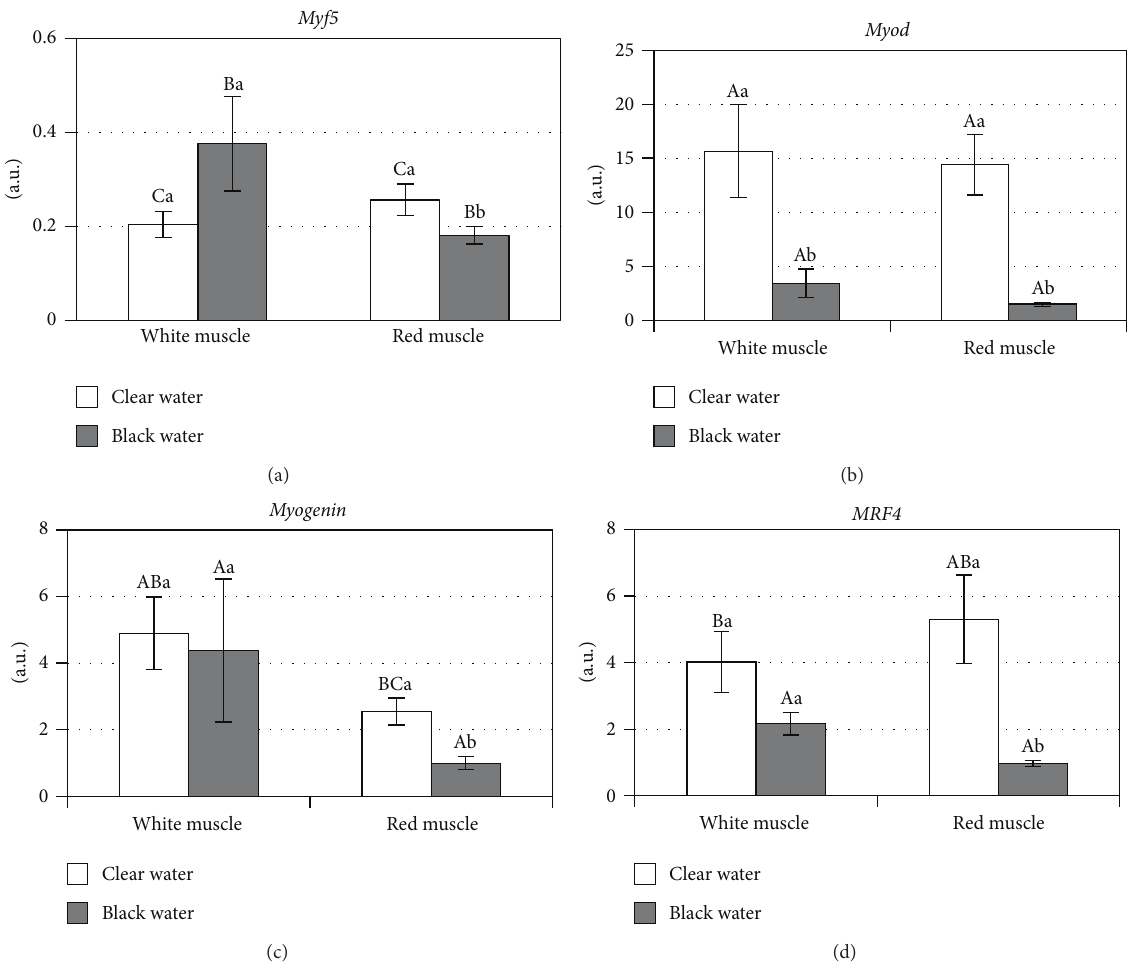
Figure 2: Comparisons of MRFs ( Myf5 , Myod , Myogenin , and MRF4 ) expression in Amazonian water types (clear and black waters). Upper case: statistical analysis of MRFs ( myf5 , myod , myogenin , and mrf4 ) transcript levels from white and red muscles. Lower case: statistical analysis of MRFs ( myf5 , myod , myogenin , and mrf4 ) transcript levels from clear and black